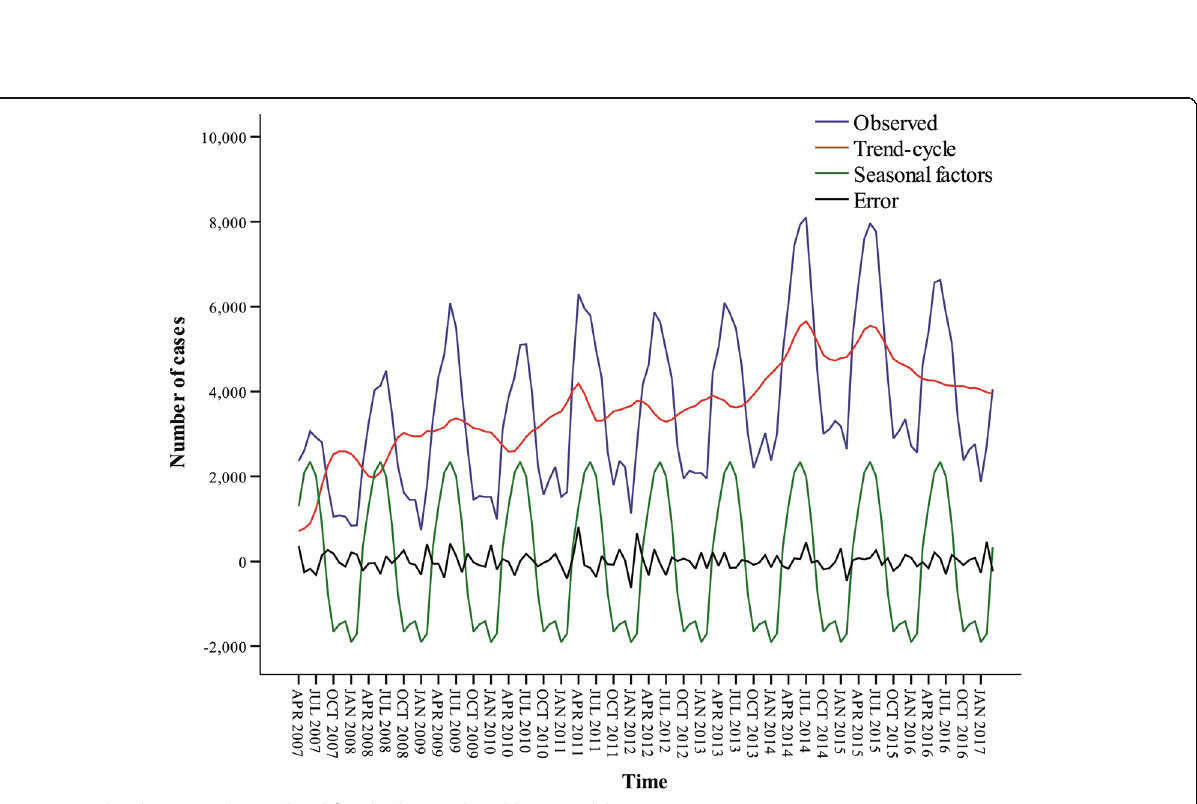
Fig. 4 Error line between observed and fitted values in the additive